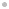
Standardized (Cohen’s d) differences of the motor performance between the control and experimental groups (grey ⦁ dots represent U15 age groups, while the ▲ black triangles represent the U17 age groups).Error bars indicate uncertainty in the true mean changes with 90% confidence intervals. Light grey zone reflects trivial values. Values towards the right means higher values for the experimental group, while higher values towards the left means higher values for the control group. RCOD: repeated change-of-direction; CMJ: counter-movement jump.